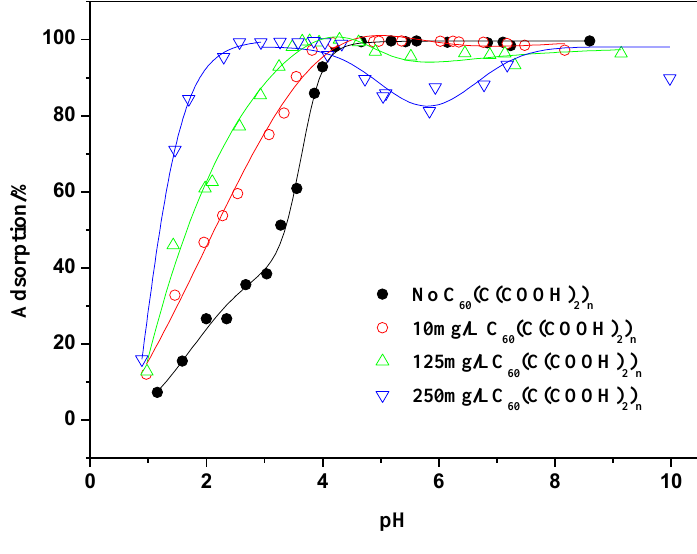
(C(COOH) ) on Th(IV) adsorption onto oMWCNTs as a function 60 2 n